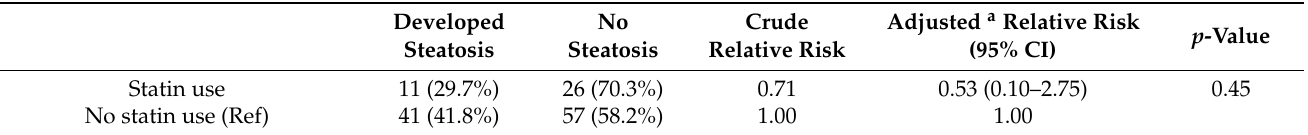
Table 6. Steatosis in patients who received adjuvant chemotherapy for their colorectal cancer based on statin administra- tion